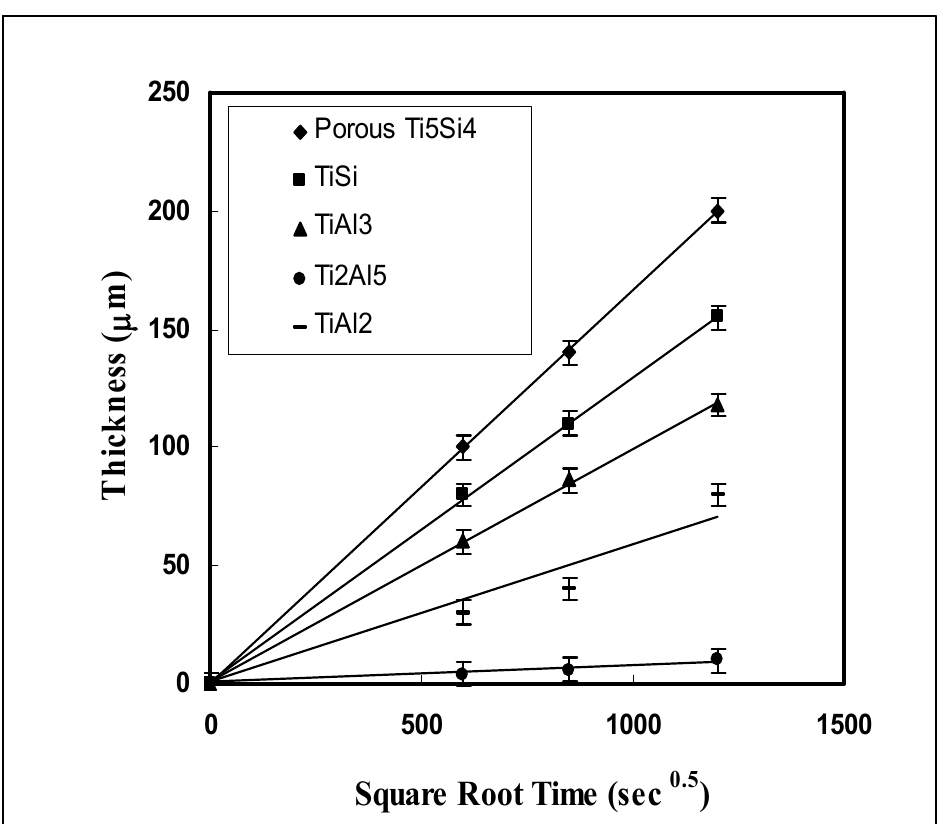
Figure 12. The growth of each product phase of TiSi 1,373 K